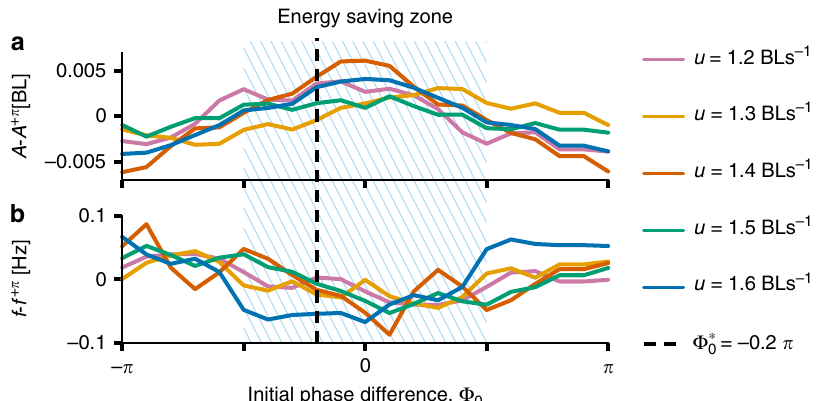
Fig. 4 Relative energetic bene fi ts to a follower in real fi sh pairs. a , b Energy cost analysis was conducted by calculating the difference in amplitude A ( a ) and frequency f ( b ) at Φ 0 and the same measurements with the opposite phase Φ 0 + π (written as A + π and f + π respectively) as a function of initial phase difference Φ 0 (Supplementary Fig. 25 and Note 4). Data are pooled from all pairs when the follower ’ s front-back positions are not >0.4 BL distance (where the hydrodynamic interactions are expected to be the strongest). The hatched areas show the energy saving zone of Φ 0 . The dashed line denotes Φ (cid:1) most typically observed initial phase difference exhibited by our fi sh. (Average amplitude is 0.09 BL, average frequency is